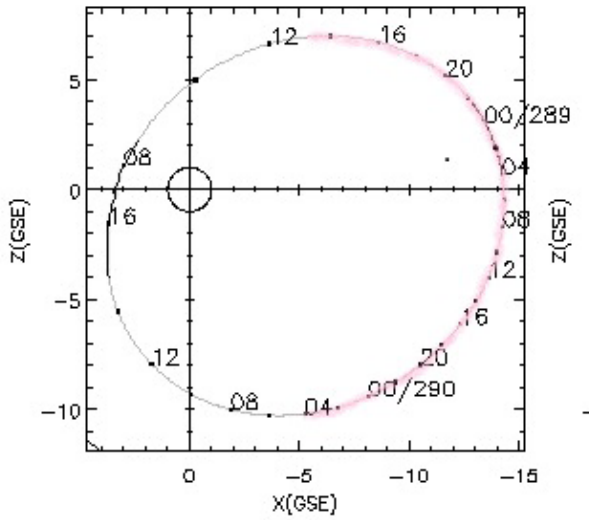
Figure 2. Cluster orbit in the XZ plane for the HILDCAA that occurred from 03:38UT on 15 October to 18:35UT on 22 Octo- ber 2003 (event number 4 in Table 1). The axes are plotted in Earth radii. The part of the orbit marked by pink represents the interval on which the Cluster crossed the magnetotail during the